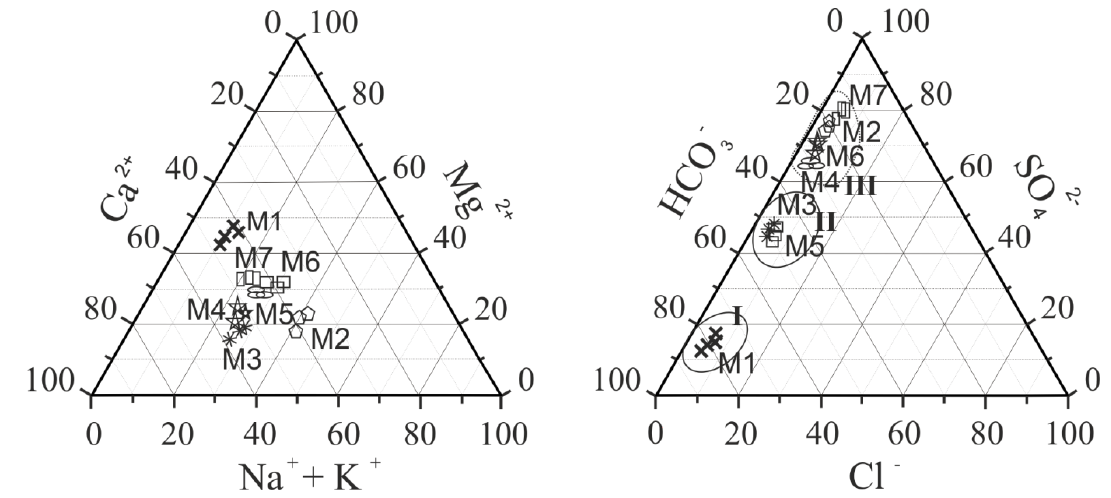
Figure 2. A triangular diagram with the data of the major ions at the sites M1–M7: I—bicarbonate class calcium-magnesium group; II—bicarbonate-sulfate class calcium-sodium group, III—sulphate class calcium-magnesium group.